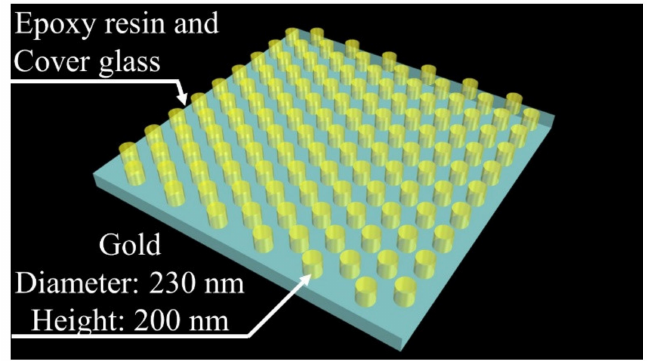
Figure 1. Schematic illustration of configuration of polymer-based